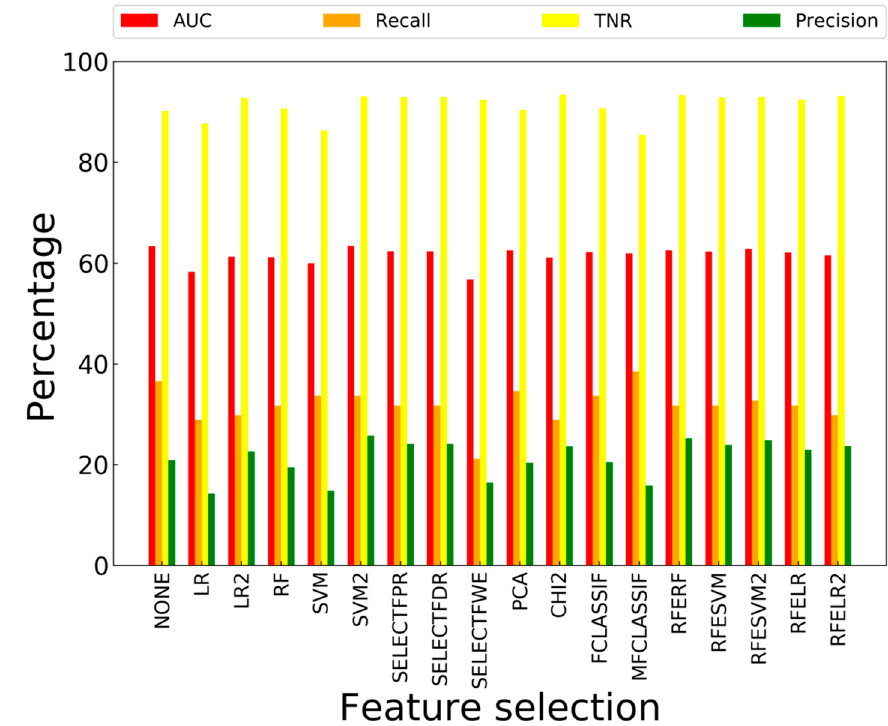
Figure 10. Classification results with the highest AUC in each feature selection on imbalanced data.